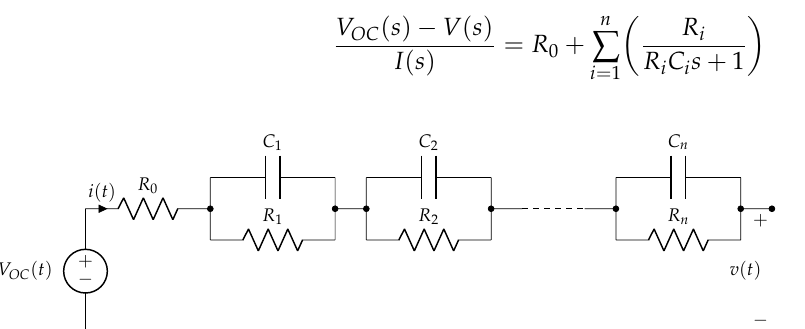
Figure 2. Thevenin-based model of n th order RC